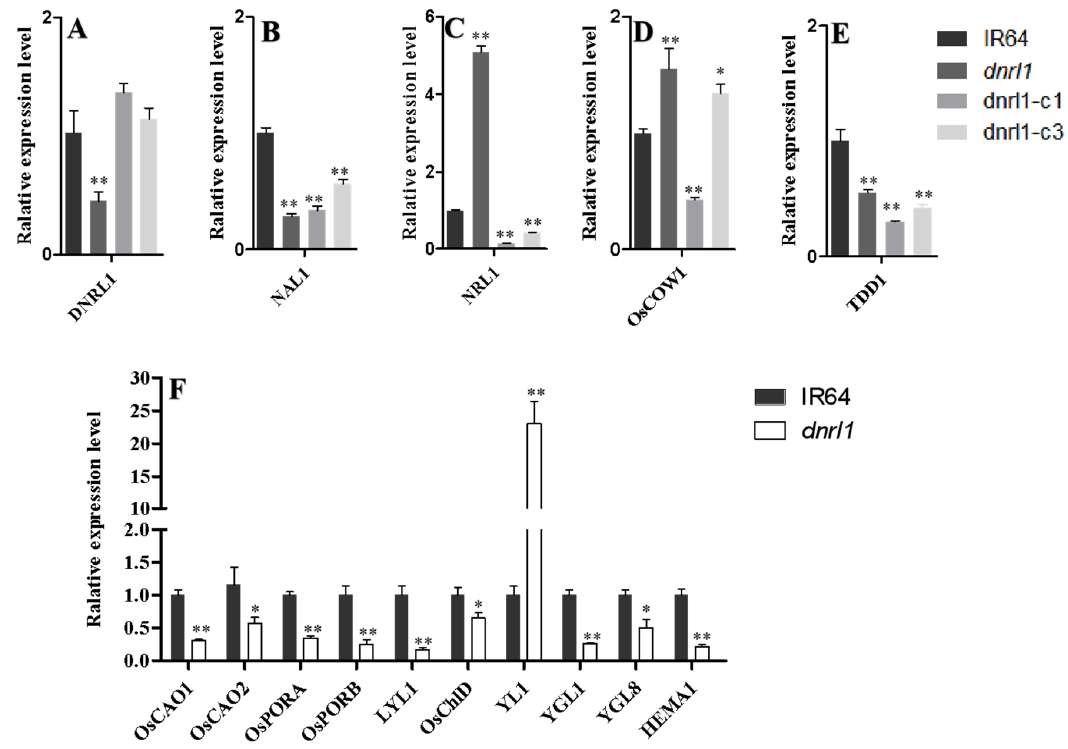
Figure 7. qRT-PCR analysis of leaf morphology and chlorophyll biosynthesis-associated genes. ( A – E ) Leaf morphology-associated genes; ( F ) chlorophyll biosynthesis-associated genes. The accession numbers and primer sequences of these genes are listed in Table S3. Values indicate means ± SD ( n = 3); * indicates significance at p ≤ 0.05; ** indicates significance at p ≤ 0.01 by Student’s t test.